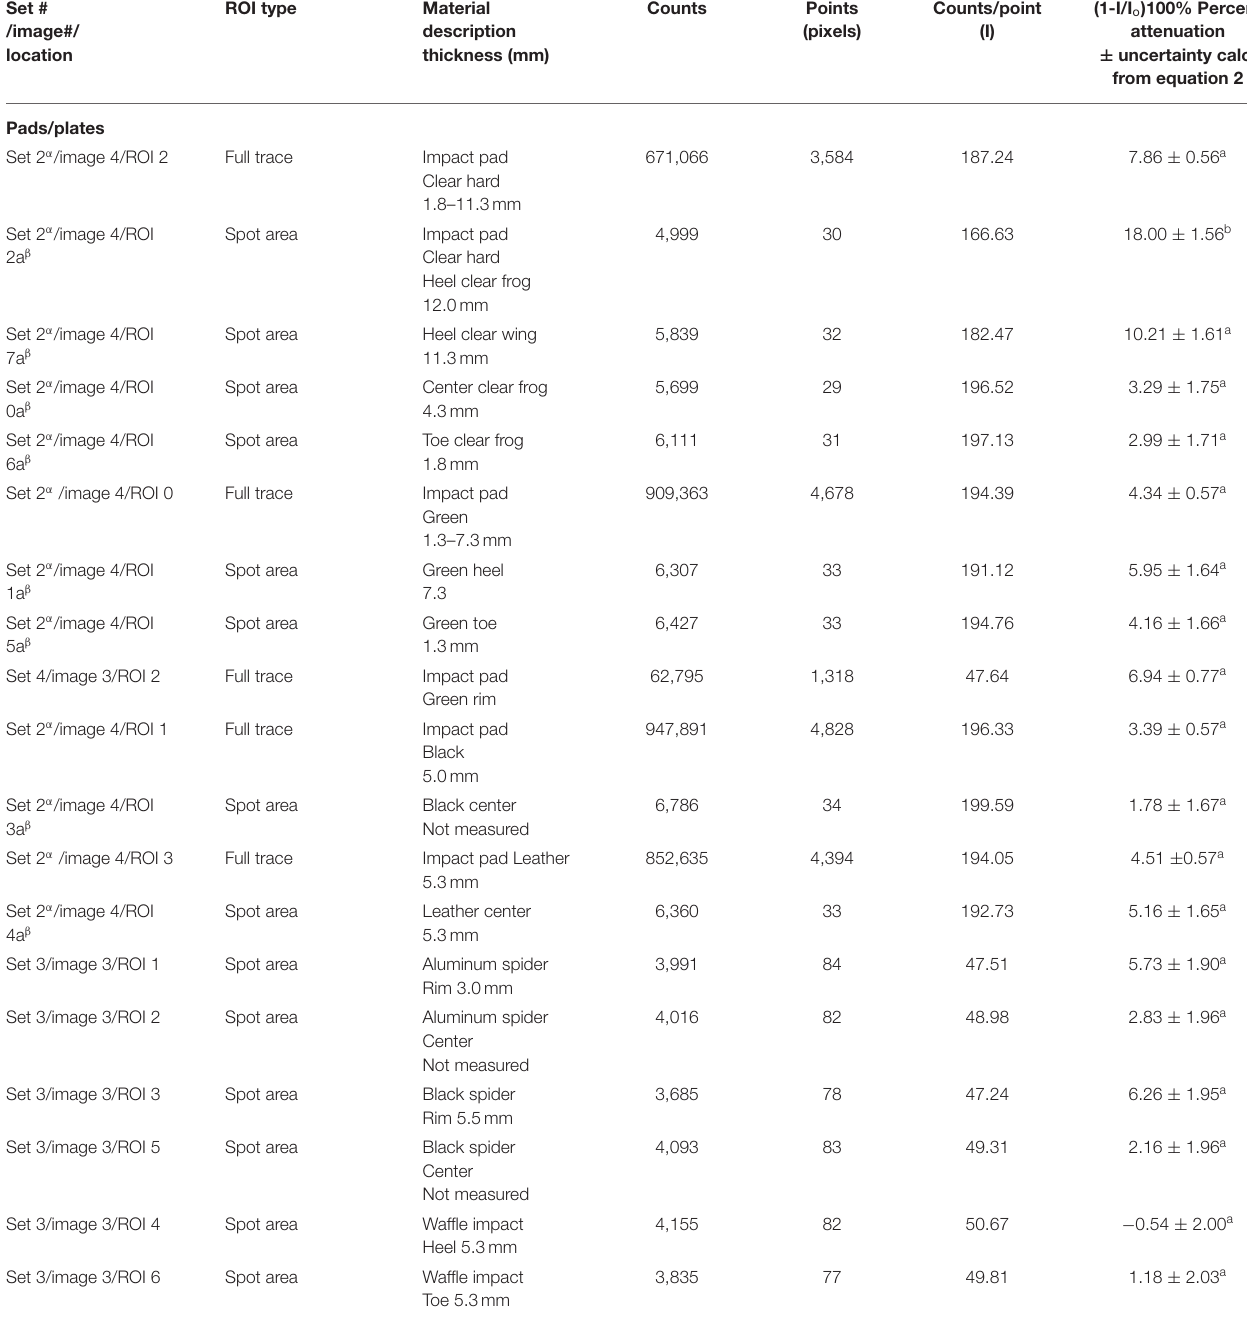
TABLE 5 | Data for Pads/Plates (I) and Attenuation Calculation.